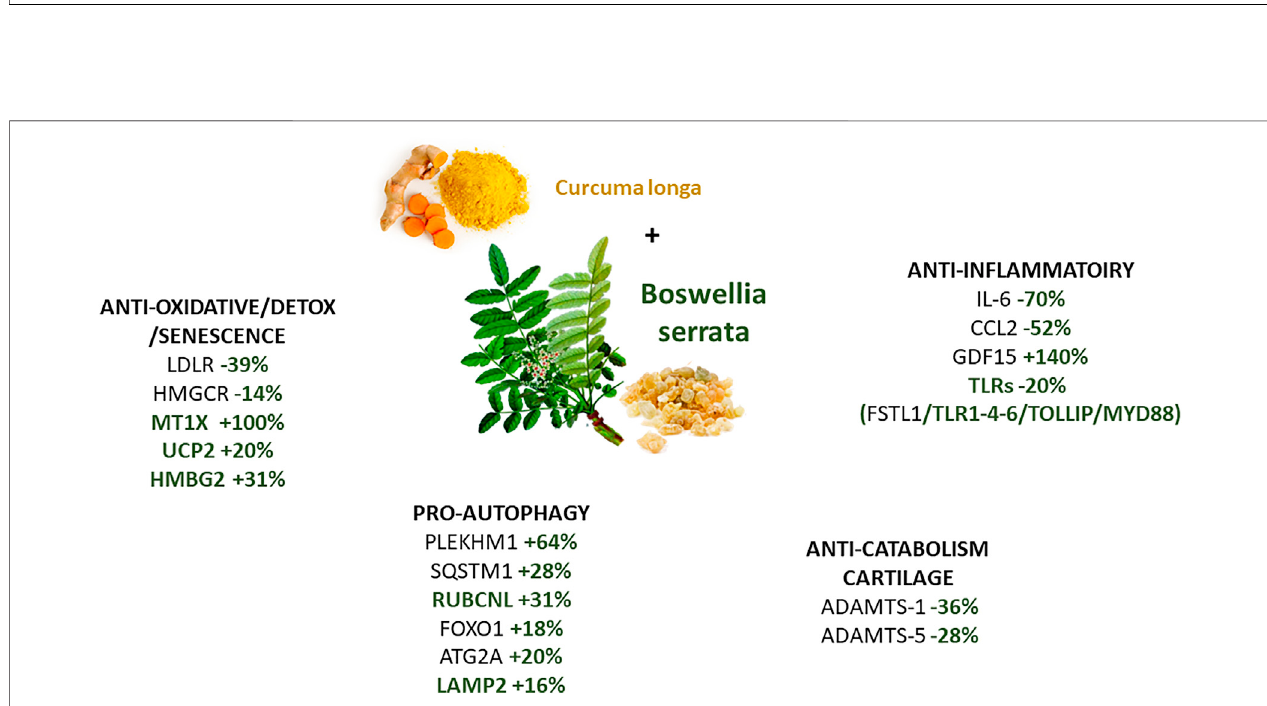
FIGURE8| Bene fi tsofusing B.serrata incombinationwith C.longa fortreatingOA.Thepercentage isshownincomparisonto C.longa alone.Genesingreenand bold are DEGs speci fi c to B. serrata treatment and unmodi fi ed with C. longa treatment.